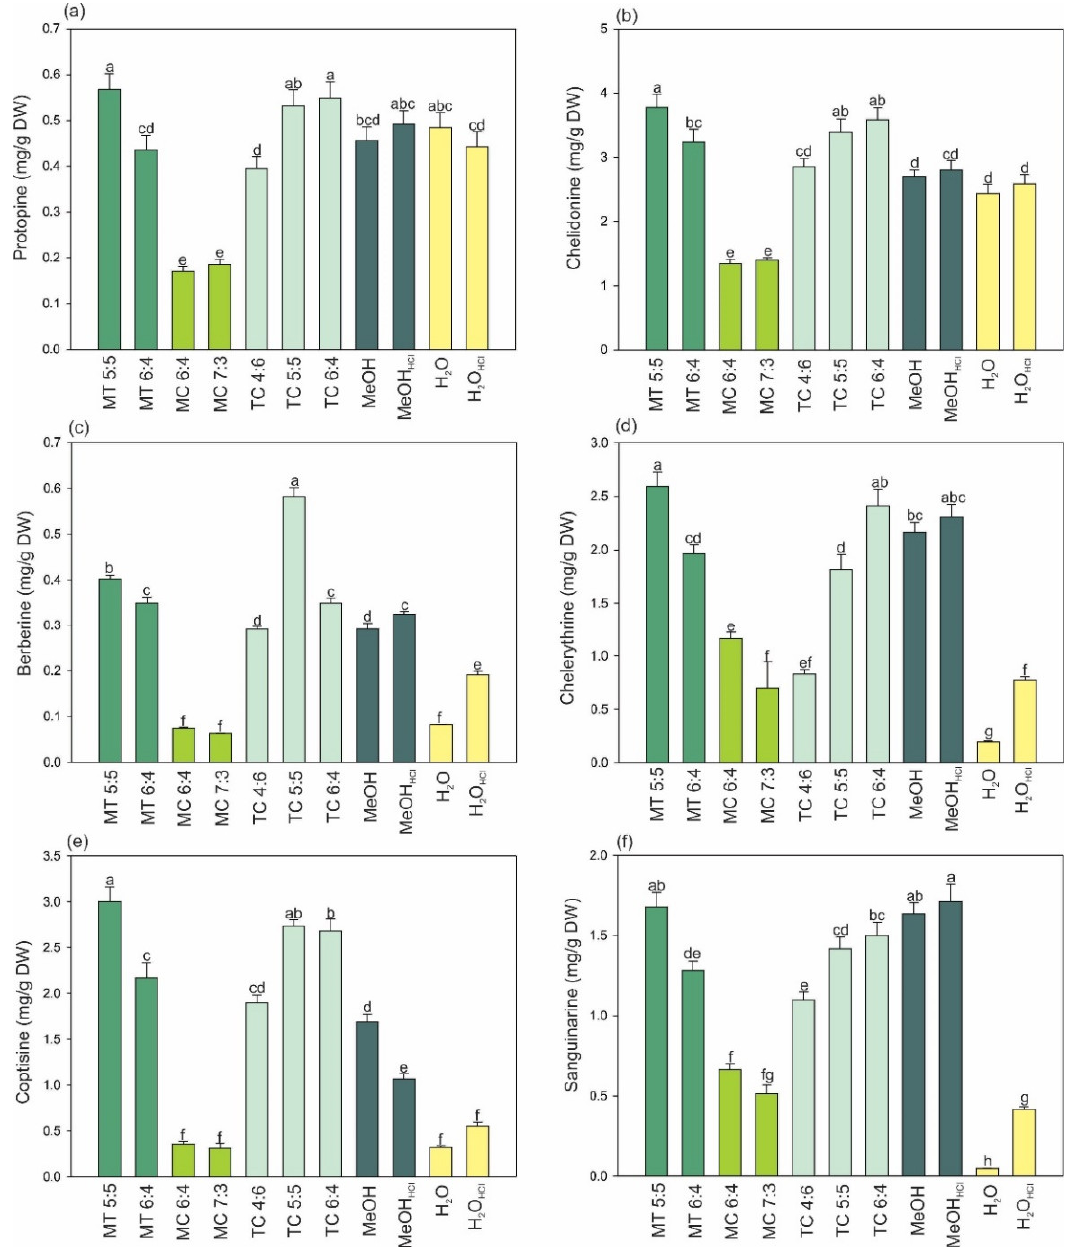
Figure 2. Yields of extraction of isoquinoline alkaloids from Chelidonium majus roots with volatile natural deep eutectic solvents and commonly used extractants; ( a – f ), yields of extraction: protopine, chelidonine, berberine, chelerythrine, coptisine, and sanguinarine respectively. MT—Menthol–thymol mixtures; MC—Menthol-camphor mixtures; TC—Thymol-camphor mixtures. The mass:mass ratio of the components in the mixtures is shown next to the symbols. MeOH HCl and H 2 O HCl -MeOH and water acidified with hydrochloric acid to a concentration of 0.05 M. Data are mean ± SE ( n = 5); values for individual raw materials followed by the same letter are not significantly different ( p < 0.05, Tukey’s test).